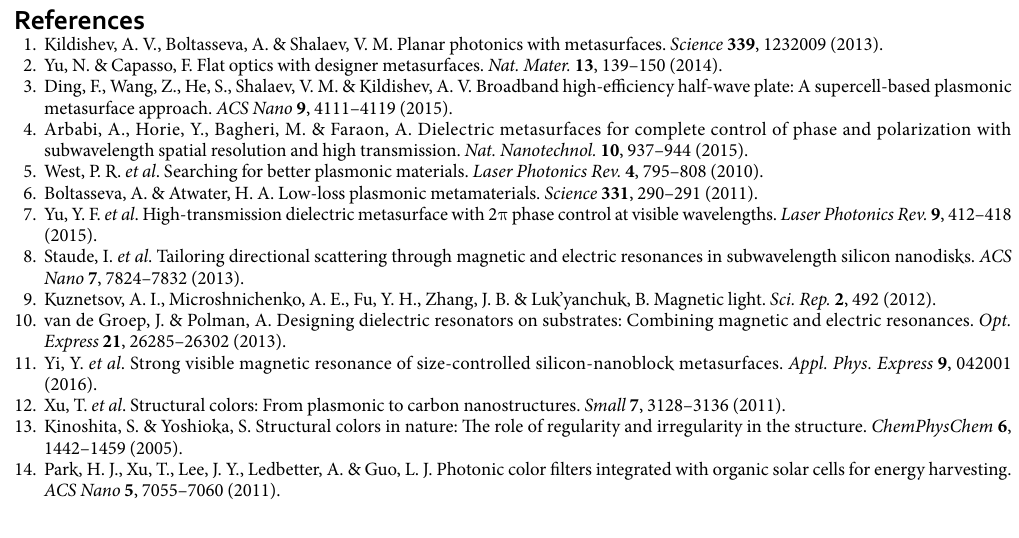
for different polarizations by launching a collimated beam via a multimode fiber, which originates from a halogen lamp (HL-2000-FHSA, Ocean Optics) that is properly polarized via a calcite crystal polarizer (GTH 10M-A, Thorlabs), to the prepared filter that is mounted on a motorized rotation stage via a focusing lens. The optical output was captured by a spectrometer (Avaspec-3648, Avantes). The images relating to each pixel of the color filter were taken by a digital microscope (Leica DM4000 M).